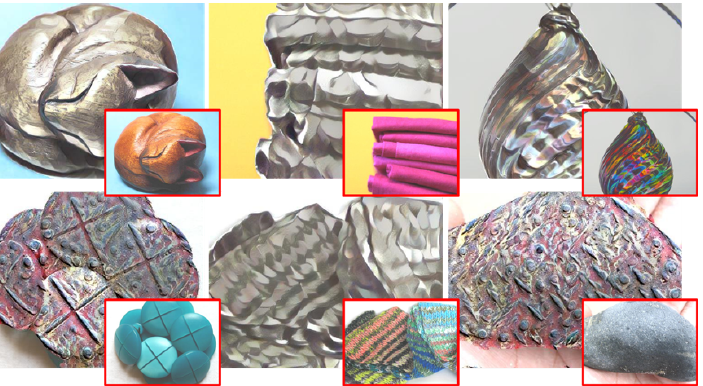
Figure 1. Examples of material translation results. Metal objects translated from different original materials: wood, fabric, glass, plastic, fabric, and stone (content image in red). From left to right and top to bottom, respectively.